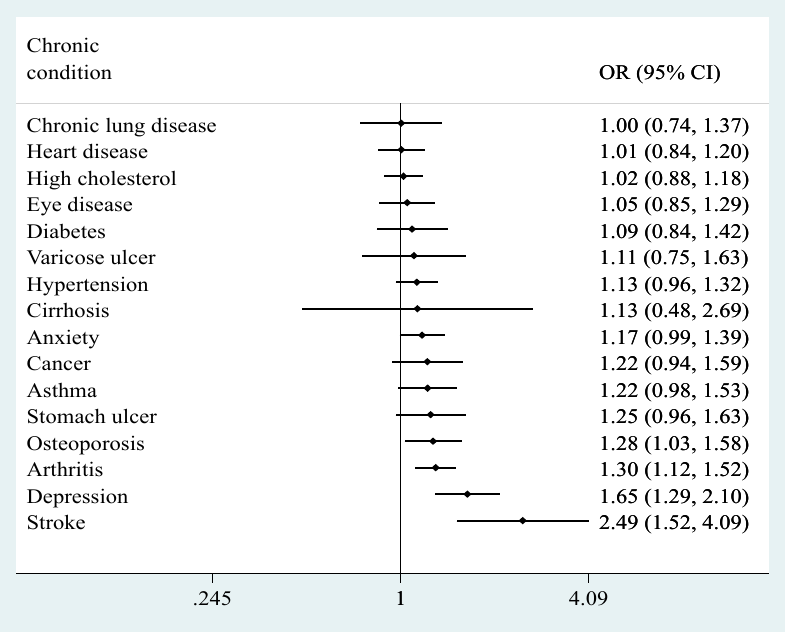
Figure 2. Prospective association between individual chronic conditions at baseline and falls at follow-up estimated by multivariable logistic regression. Abbreviations: OR, odds ratio; CI, confidence interval. Falls were those which were assessed at Wave 2 and referred to those that occurred since Wave 1. The logistic regression model was mutually adjusted for all individual chronic conditions, as well as sex, age, education, marital status, alcohol consumption, and previous